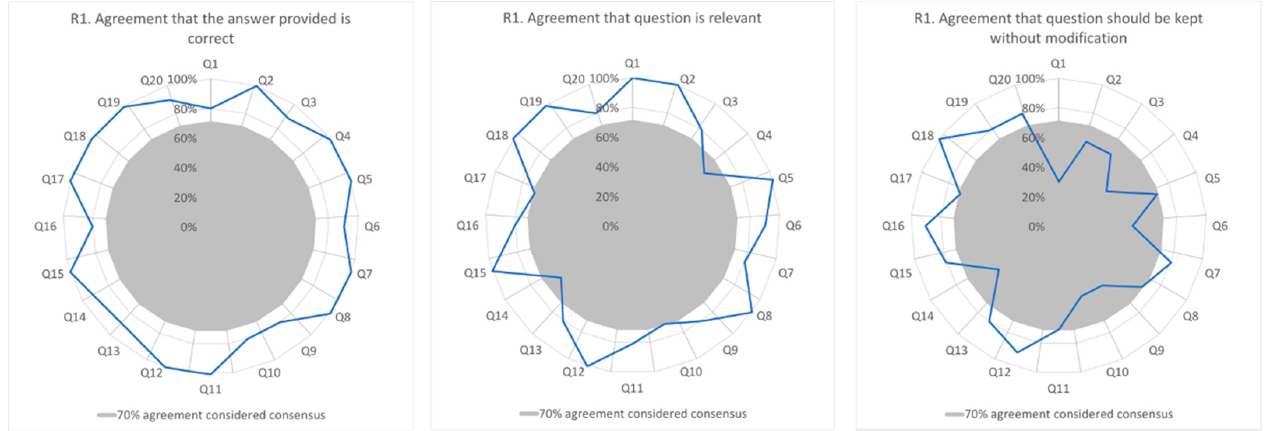
Figure 1. Delphi Round 1 participant responses ( n = 10), in relation to agreement of answer, relevancy, and whether modification is required. Q= question number.